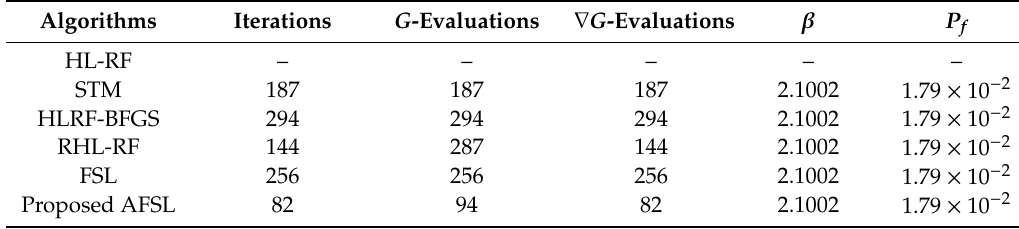
Table 7. Results of di ff erent algorithms for Example